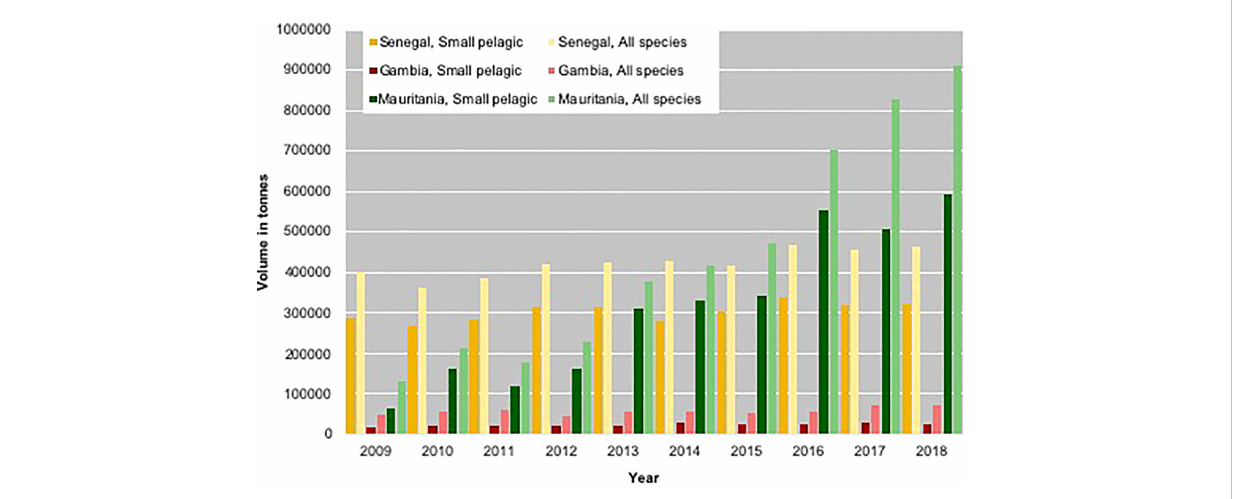
FIGURE 2 Total catches and share of small pelagics in Senegal, the Gambia and Mauritania. Source: GBOS, IMROP, CRODT. 1 This fi gure presents the total productions small pelagic (artisanal and industrial fi sheries). Small pelagic in Senegal are exclusively exploited by artisanal fi shing. While in The Gambia and Mauritania, they are exploited by the artisanal and industrial fi